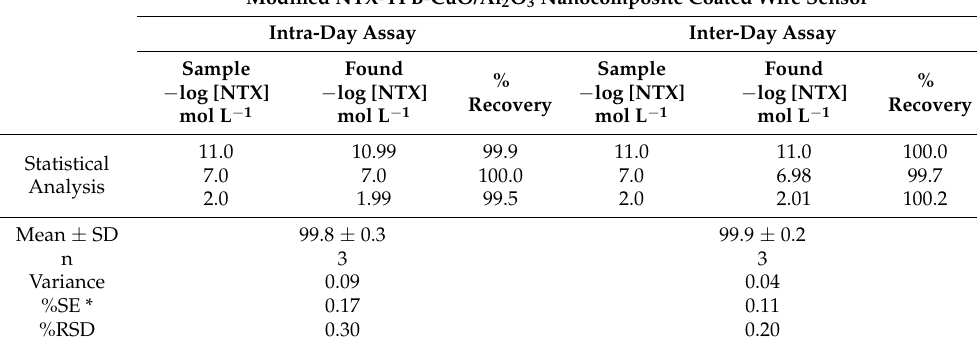
Table 5. Intermediate precision assay of the designed modified NTX-TPB-CuO/Al 2 O 3 nanocomposite coated wire sensors.